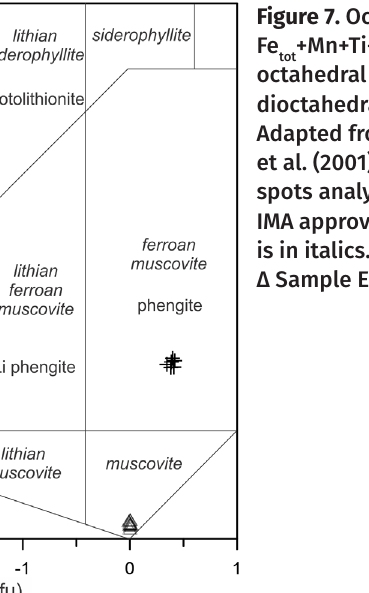
Figure 7. Octahedral Fe +Mn+Ti-Al VI versus tot octahedral Mg-Li for dioctahedral micas.